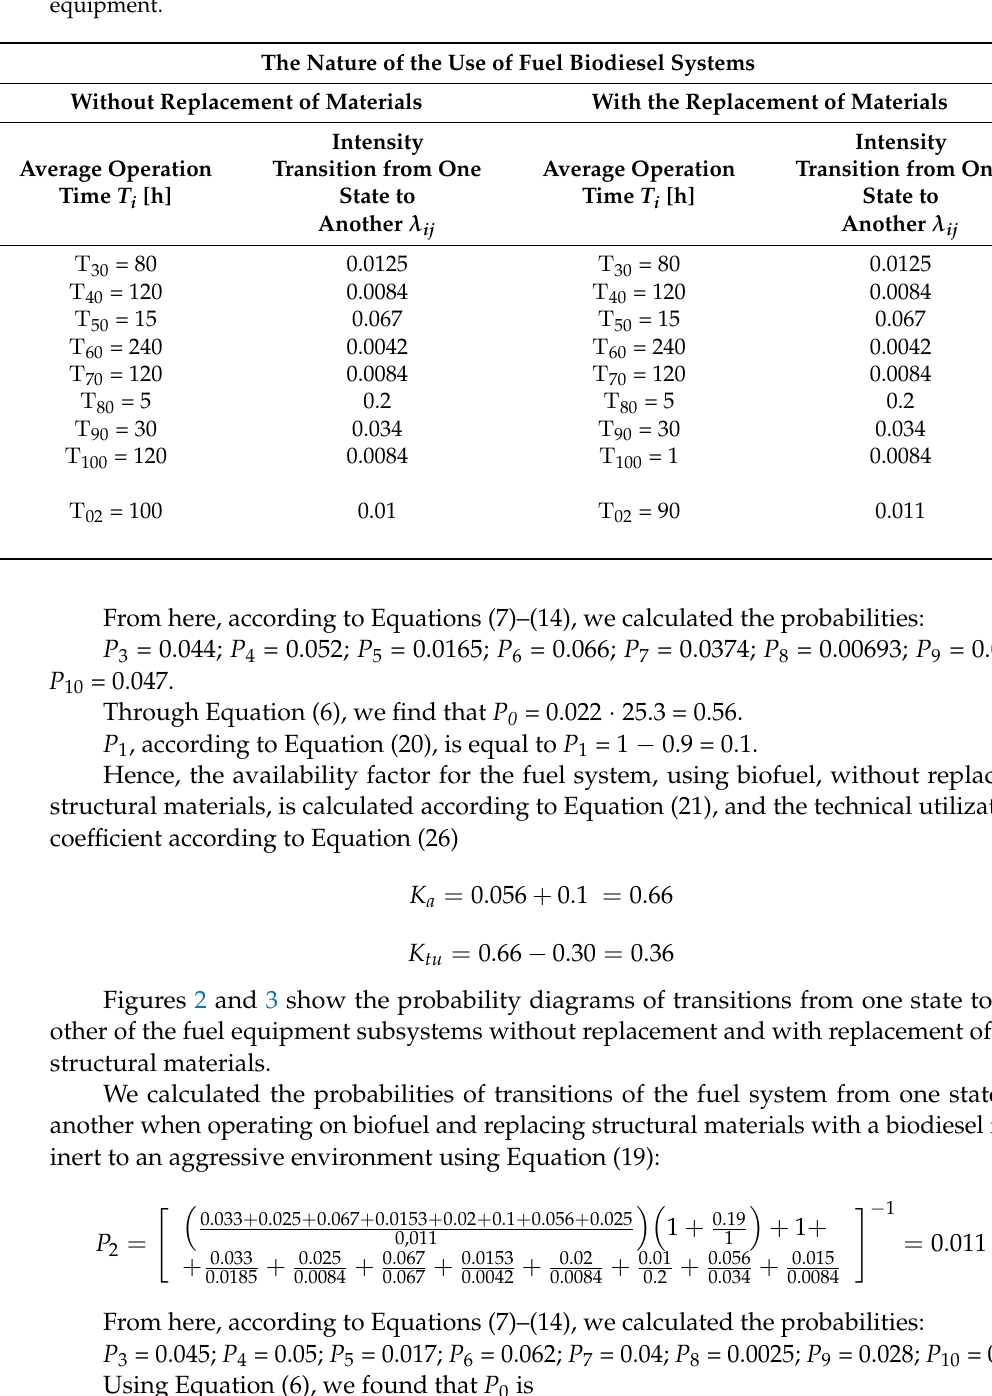
Table 2. Average values of time for performing technological operations for the repair of fuel